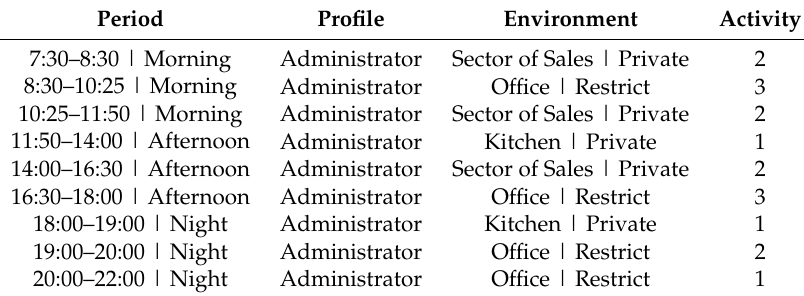
Table 13. Owner user